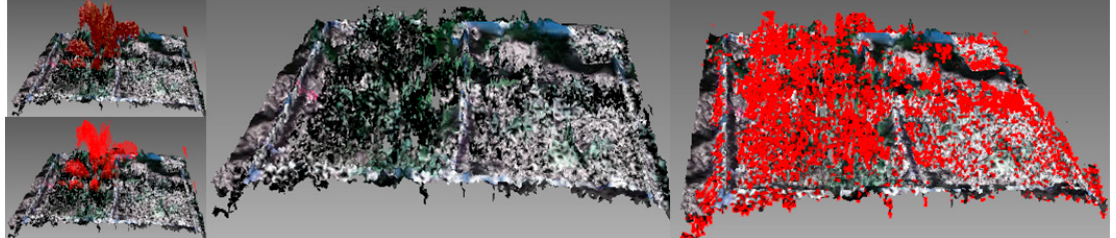
Figure 4. An example of maize isolation and removal by height selection, and an example of color selection for weed extraction.